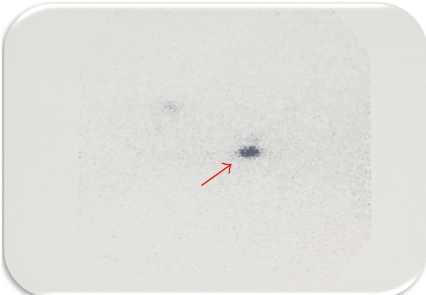
Figure 1: Cervical spine CT: complex right neck 2.6 cm × 2.3 cm mass incidentally noted as the posterior aspect of the jugular chain. It showed predominant decrease (20HU) with a solid nodule (40HU) posteriorly containing punctuate calcifications measuring 1.3 cm. Red arrow indicates right neck mass.